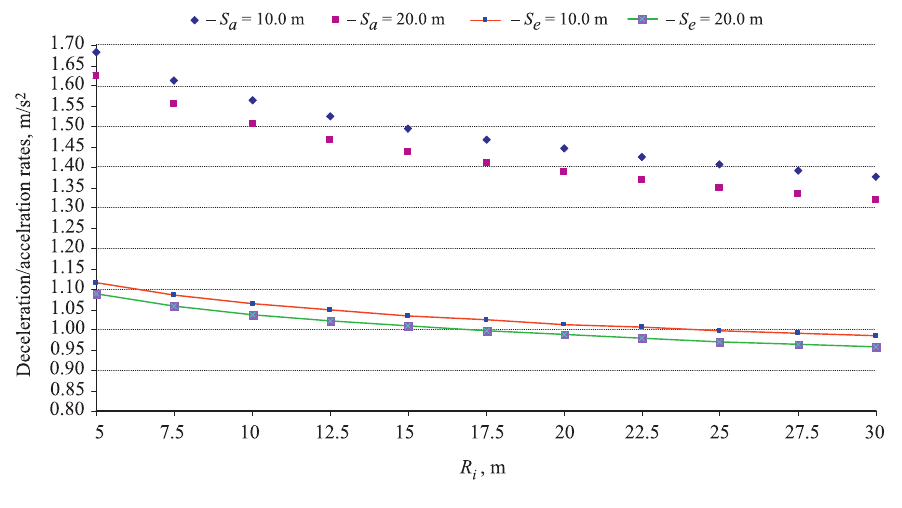
Fig. 8. Deceleration/acceleration rates – R